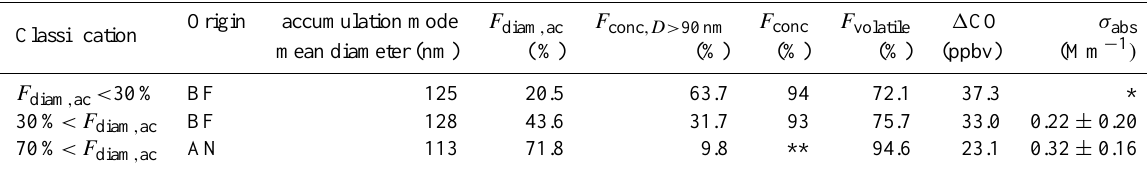
Table 4. Various parameters calculated from the analysis of ambient and elevated temperature size distributions (accumulation mode modal diameter, F conc , ac , F volatile , ac , F volatile , ratio of refractory particles with diameter larger than 10nm, ratio of volatile particles with diameter larger than 90nm, 1 CO, σ abs ) classified as a function of F diam , ac